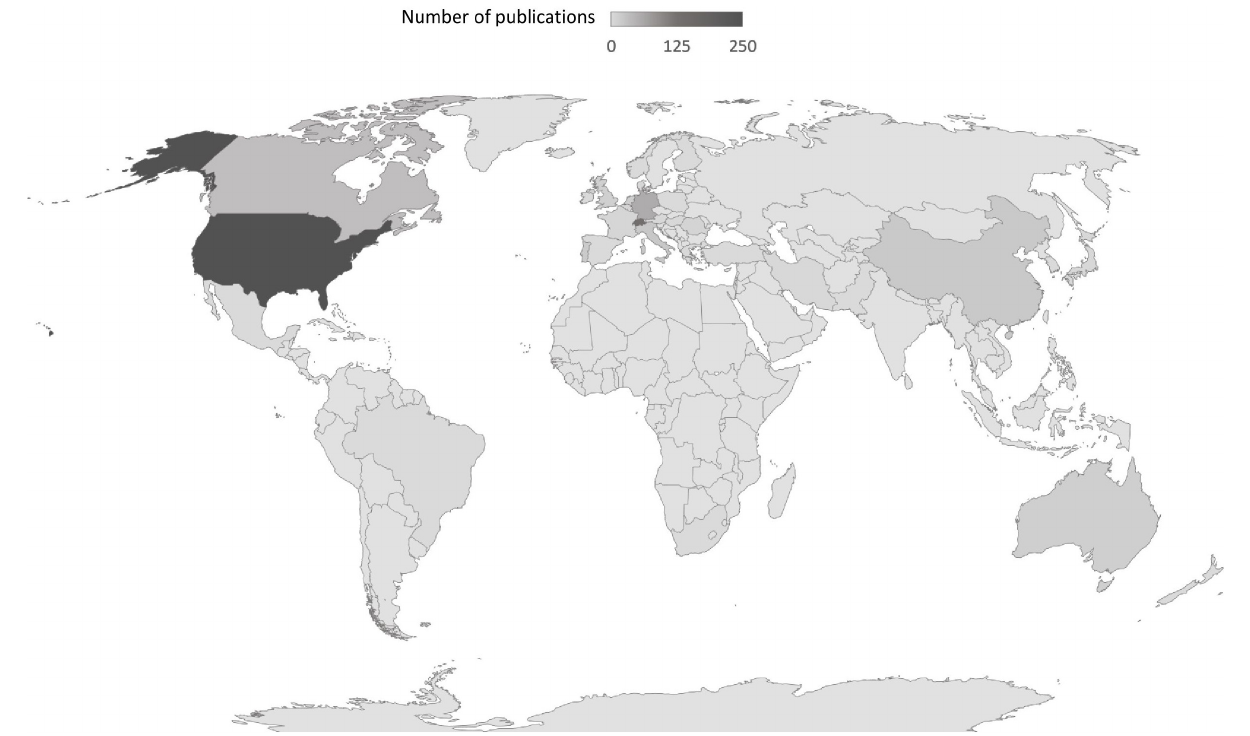
publications (22.4%) and Germany with 55 publications (8.6%).